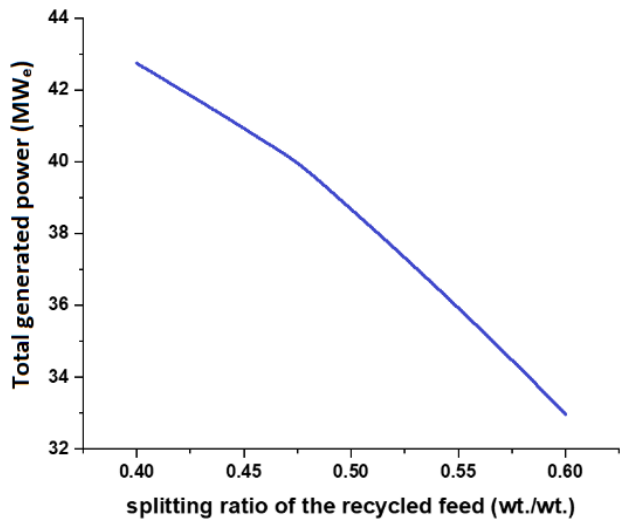
Figure 9. Effect of the purge splitting ratio on the produced power.